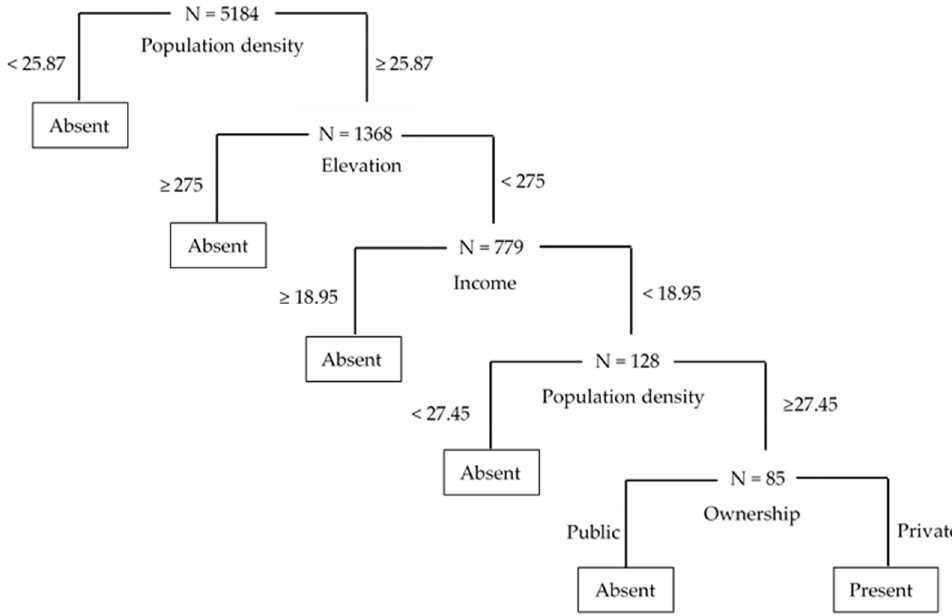
Figure 2. A classification tree to reflect most relevant factors affecting the presence of invasive tree species in Mississippi from 2009 to 2015. Forests 2018 , 9 , 38